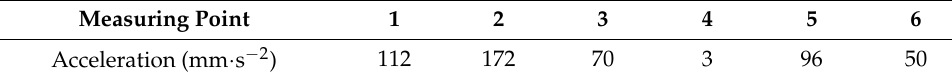
Figure 7. Dynamic data acquisition and processing system [34]. Table 1. Vibration test results [34].